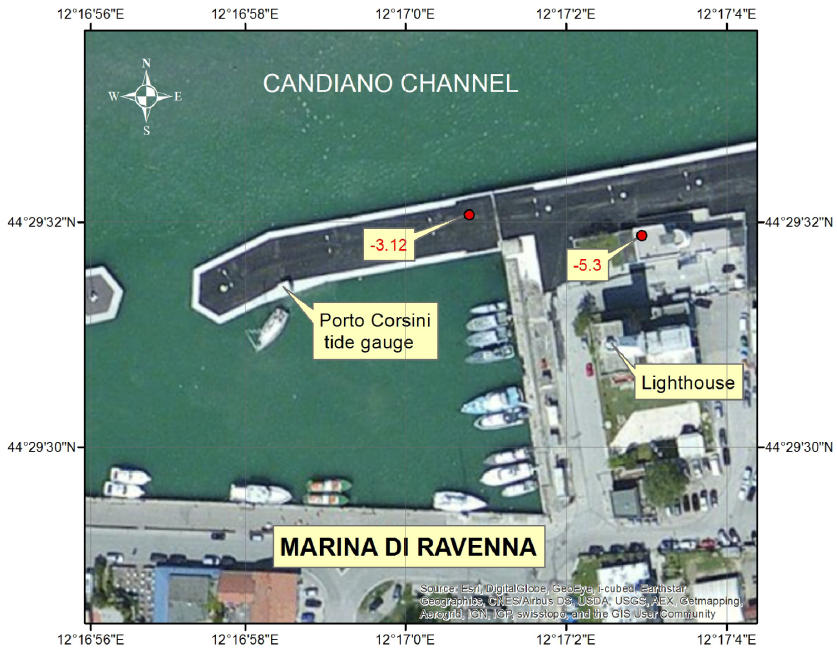
Figure 3. Aerial view of Marina di Ravenna showing the Porto Corsini tide gauge station and the surroundings. The ARPAE benchmark is sited in the same place of the tide gauge. The altimetric reference is the benchmark of the lighthouse. Red dots mark the scatter points from the interferometric satellite considered in this work, for the period 2006-2011 (units are mm yr −1 ).